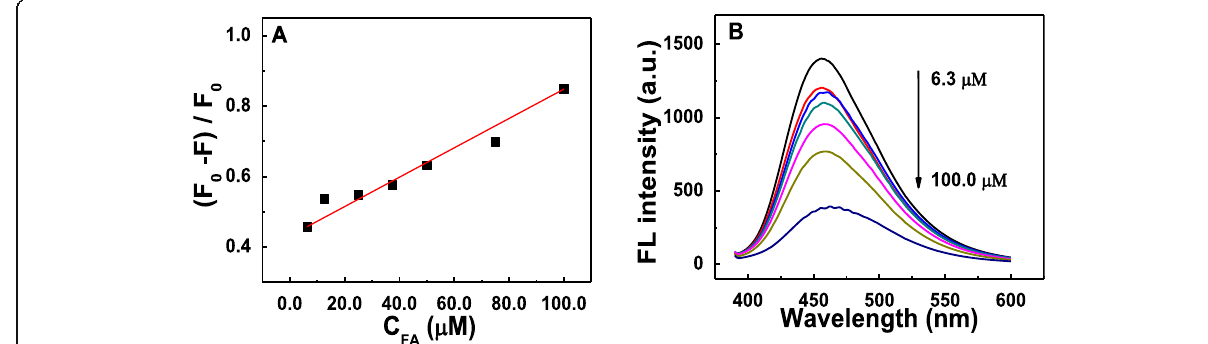
Fig. 6 a Linear relationship between FA concentration and ( F 0 - F )/ F 0 . b Fluorescence intensity of D -Trp@AuNCs after adding FA